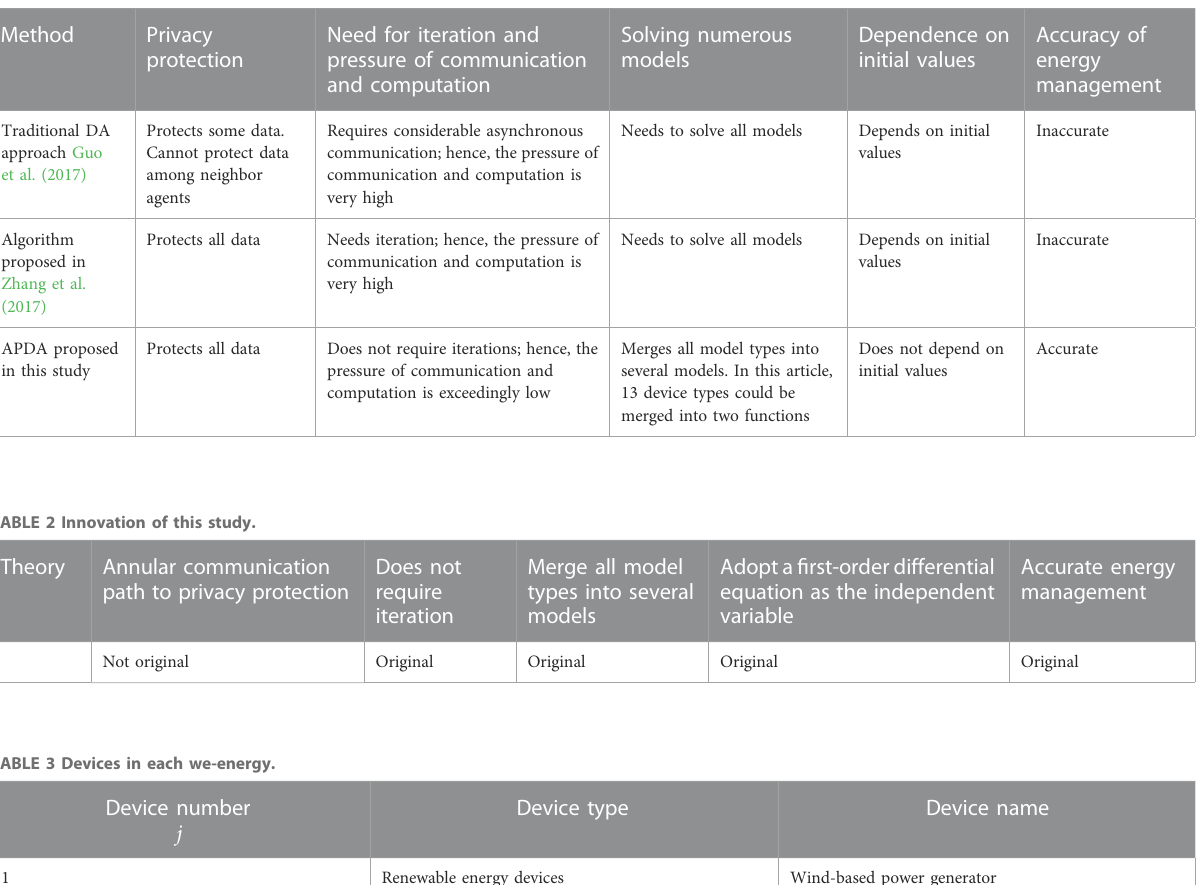
TABLE 1 Contributions of different methods.